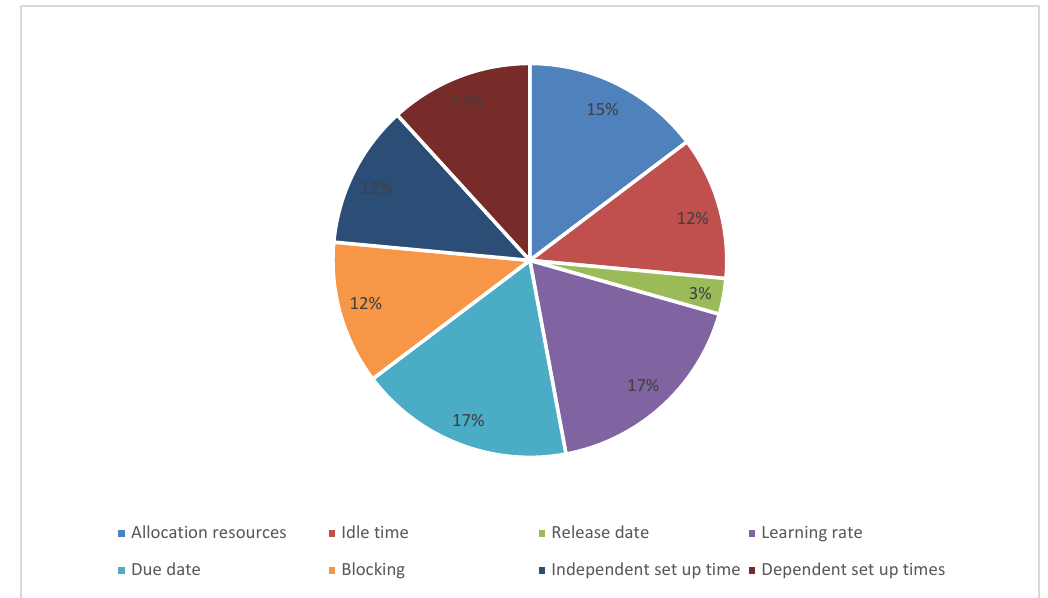
Fig. 1. Features of the NWFSP studied in the last five years. Made by the